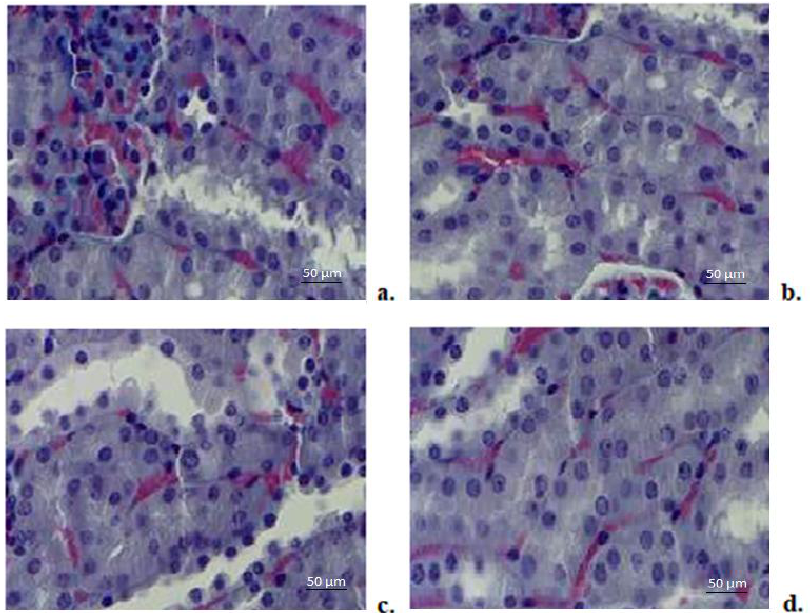
Figure 10. Histopathological examination of kidney fragments taken from rats treated with bi-distilled water ( a ), CHIT ( b ), DCF ( c ), DCF-ves ( d ) – Masson trichrome staining x 20.